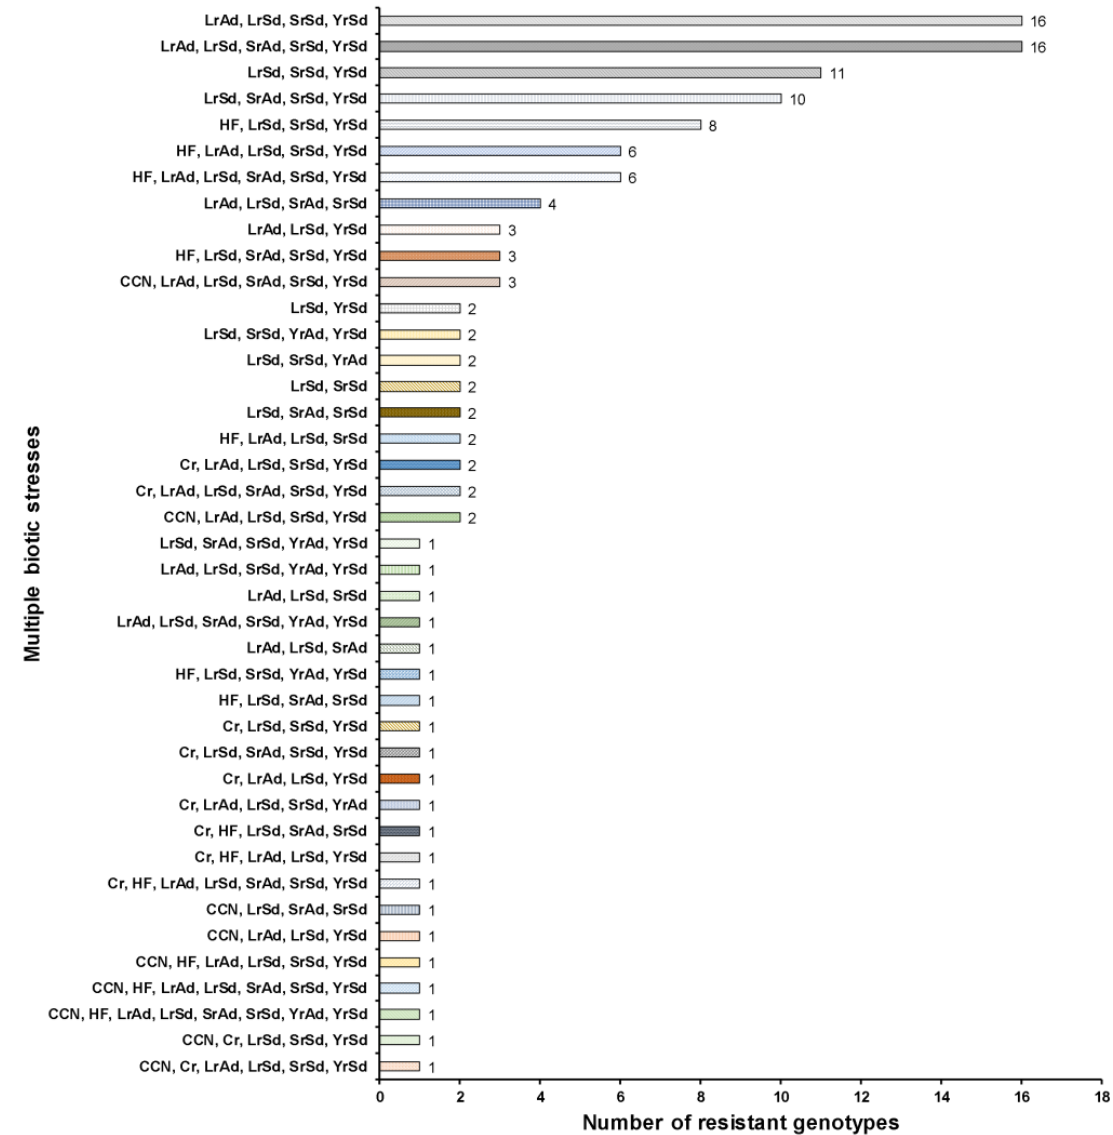
Figure 3. Number of synthetic hexaploid wheat lines showing resistance to multiple biotic stresses. CCN, cereal cyst nematode; Cr, crown rot; HF, Hessian fly; Lr, leaf rust; Sr, stem rust; Yr, stripe rust; Sd, seedling stage; and Ad, adult stage.